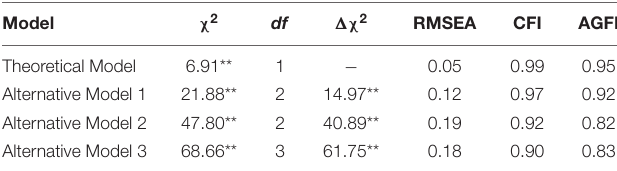
TABLE 3 | Comparison of structural equation models for employee’s psychological